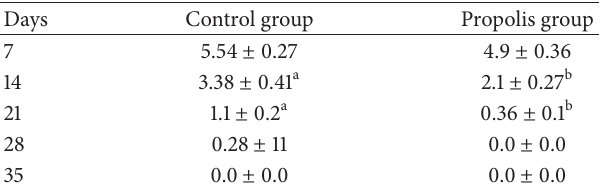
Table 1: Mean ± SD of wound surface area (cm 2 ) in both groups on different days after